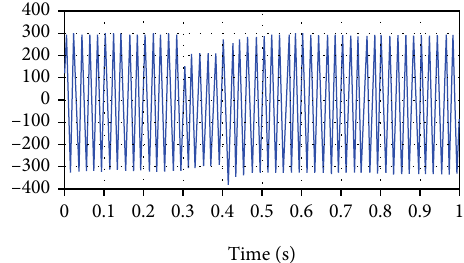
Figure 15: Voltage v